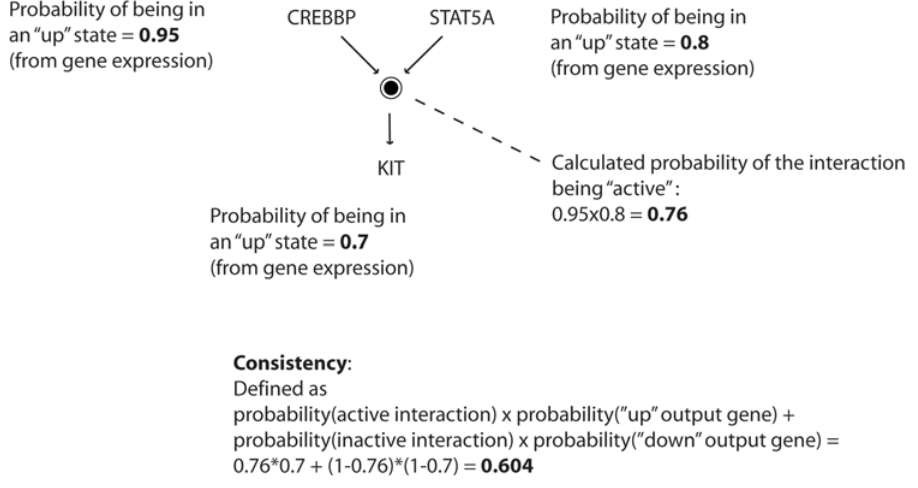
Figure 2. An example to calculating the consistency and activity of a single interaction. See Methods for details.